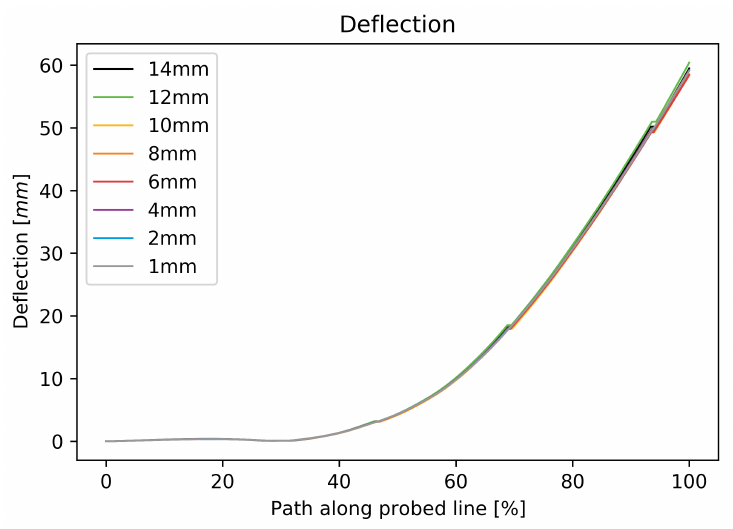
Figure 16. Convergence for